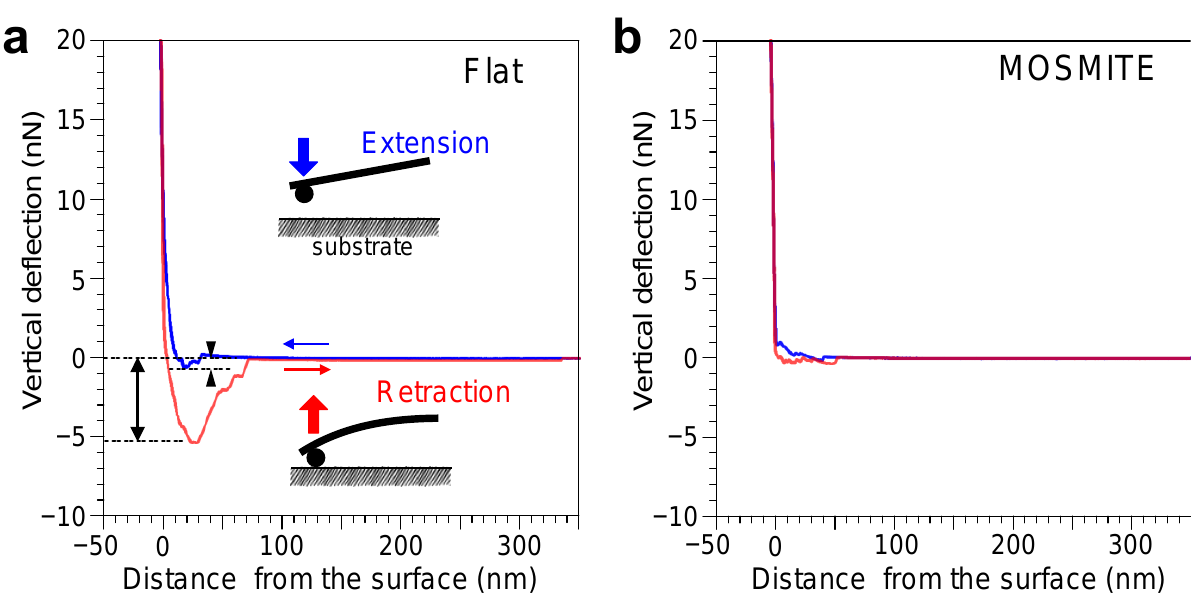
Figure 3. Measurement of adsorption force and adhesive force on the flat surface ( a ) and MOSMITE™